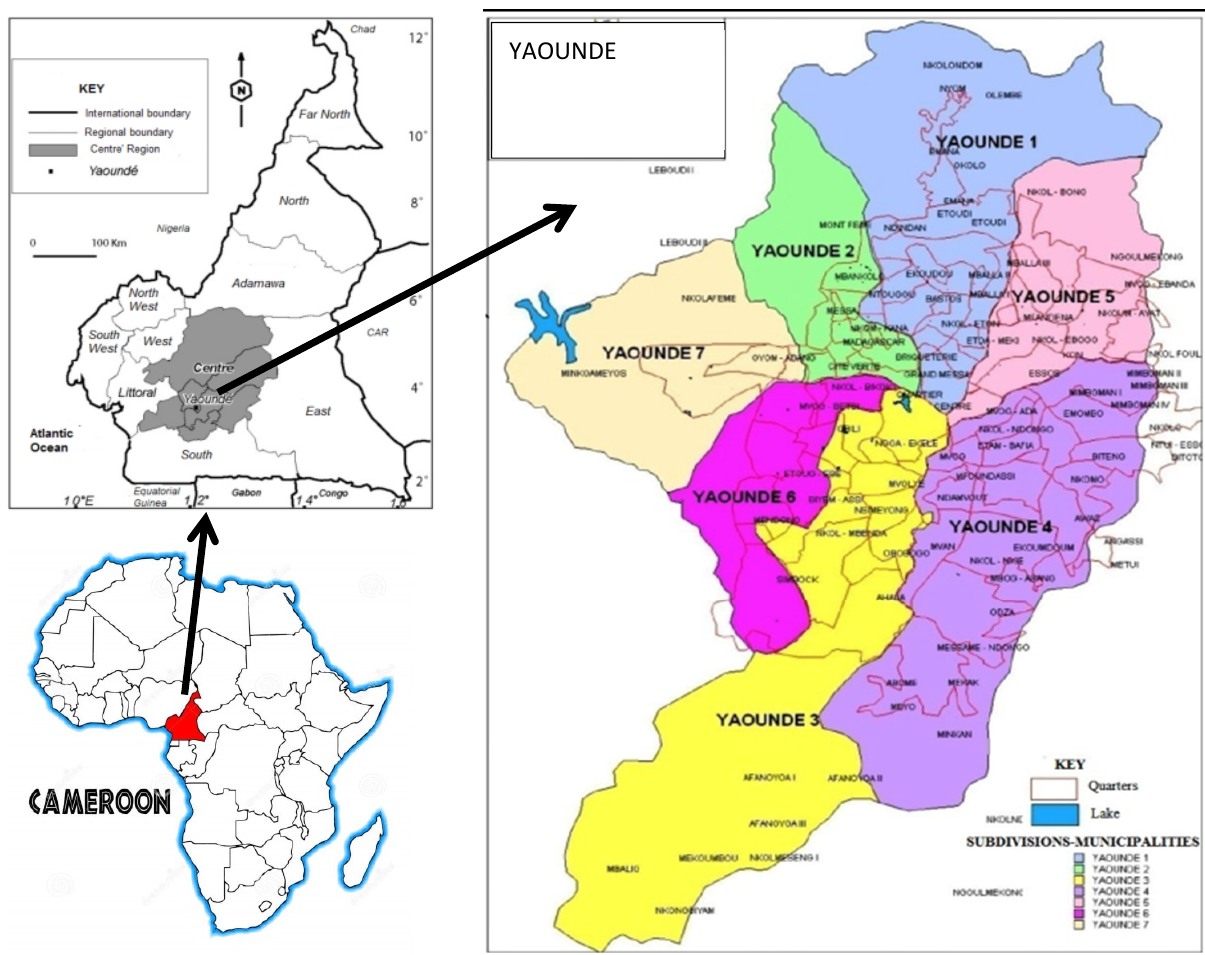
Figure 1. Map of Yaoundé showing the studied subdivisions municipalities. Map by «Syst è me d“Information G é ographique», Communaut é Urbaine de Yaound é , Cameroon,